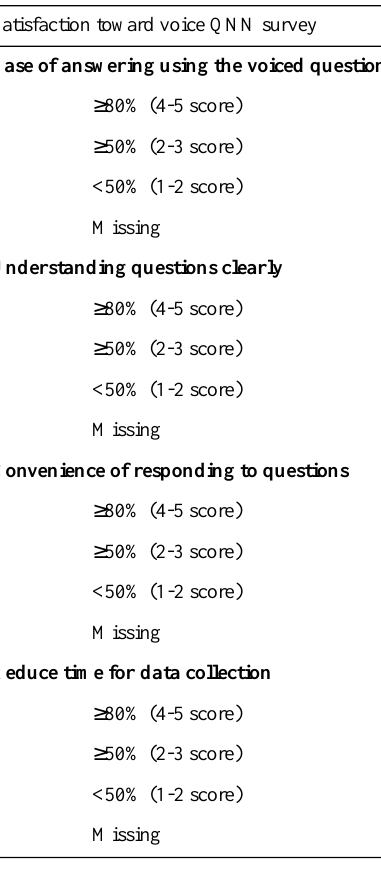
Table 3. Participant’s satisfaction toward the smartphone questionnaire survey (N=70).